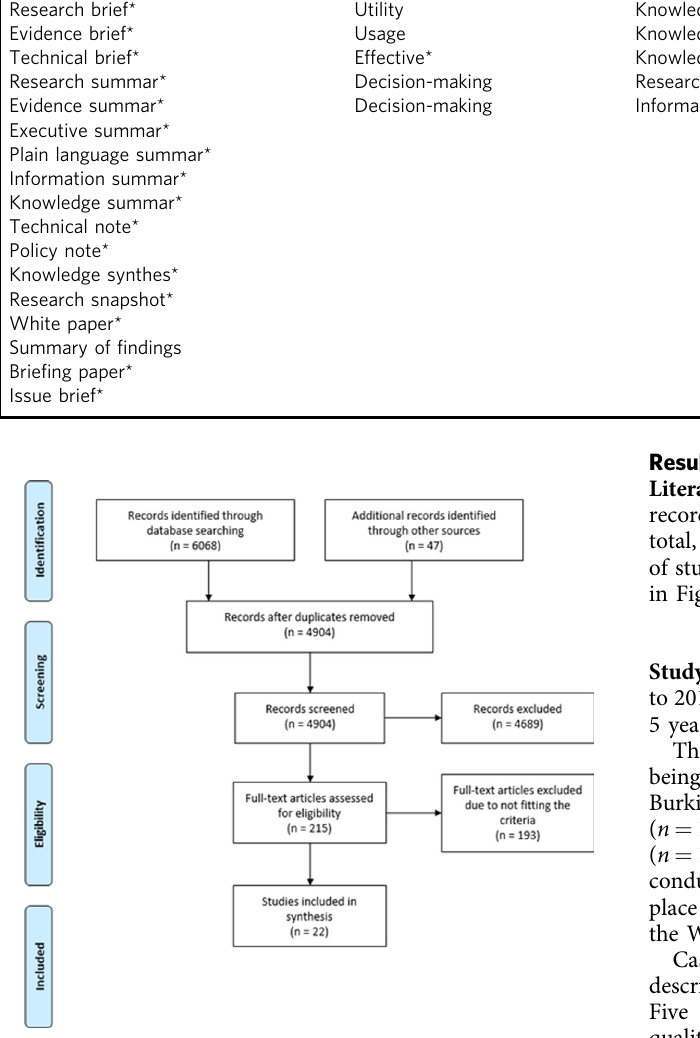
Fig. 1 PRISMA fl ow diagram. A diagram of the number of records identi fi ed, included and excluded in the